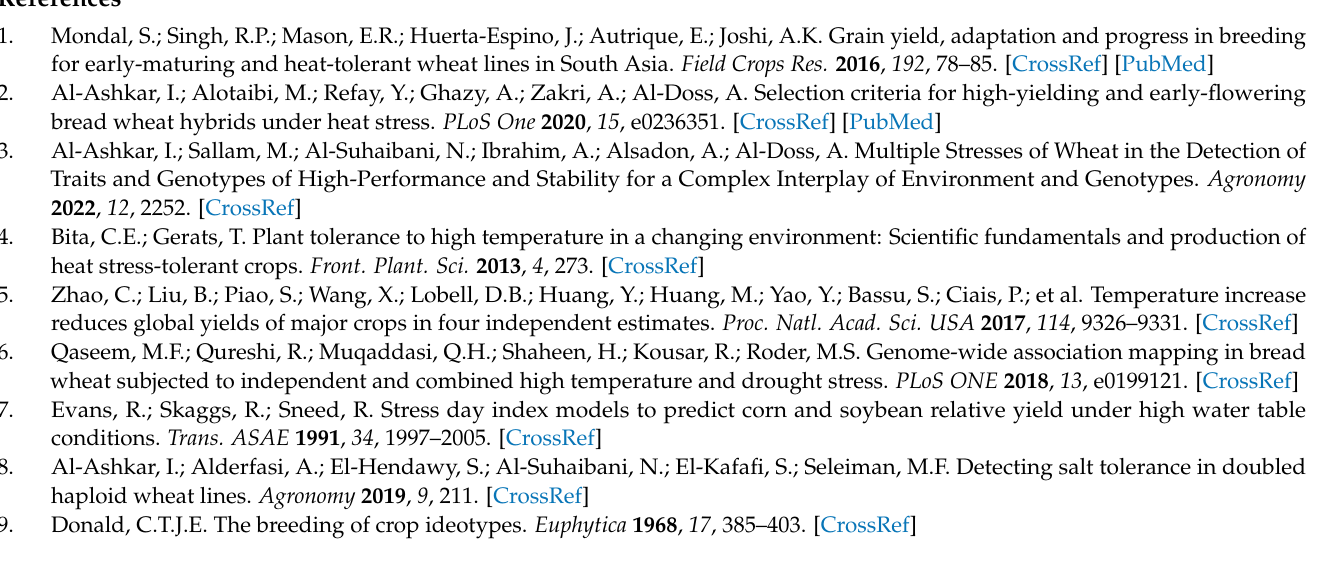
Table S5. Phenotypic (upper diagonal) and genotpic (below diagonal) correlations among 20 studied traits obtained from nine environments (n = 180). Figure S1. Estimated variance components for 20 studied traits for 20 wheat genotypes in nine